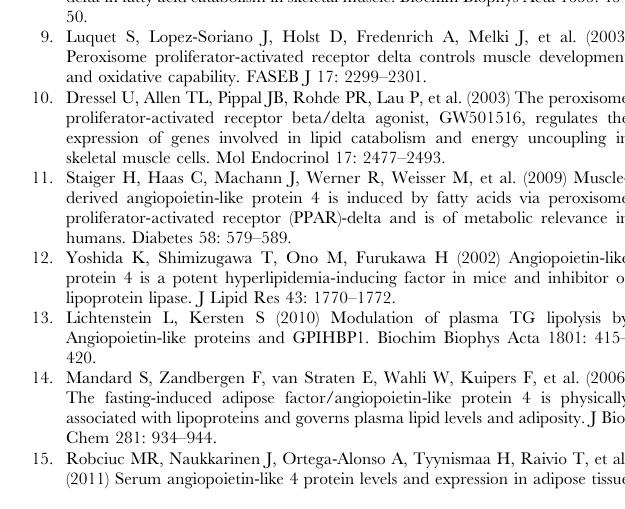
Figure S4 Efficiency of mAngptl4 gene silencing in C2/ LPL cells. Mouse Angptl4 mRNA levels were measured by real time PCR in C2/LPL myotubes transfected with non targeting siRNA (NT-siRNA) or Angptl4 siRNA. Values are normalized to HPRT and expressed as mean 6 SEM, n = 3. (PDF) Figure S5 Specificity of Angptl4 and LPL immunostain- ings. C2/LPL myoblasts were either transfected with the empty vector (mock, a ) or with Angptl4-V5 (Angptl4, b ) and immuno- stained using anti-V5 mAb, FITC Conjugate. Cells were stained with anti-LPL immunopurified IgY that was either preincubated with bovine LPL ( + bovine LPL, c ) or without bovine LPL ( 2 bovine LPL, d ). DAPI was used to stain the nuclei (blue). Wide- field fluorescence images were acquired with using Axioplan 2 Imaging E (Zeiss) microscope. Scale bar: 50 m m. Table S1 Primers utilized for Real Time PCR. Methods S1 Supplementary methods for